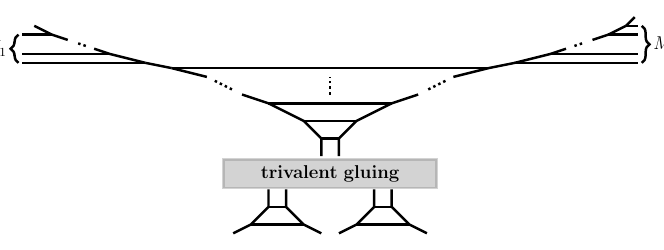
Figure 5 . A 5-brane web-like description for the SO(2 N + 4) gauge theory with M 1 + M 2 hyper- multiplets in the vector representation by replacing the web for the SO(4) part with the two webs for the pure SU(2). The three 5-brane webs are connected by the trivalent gluing.